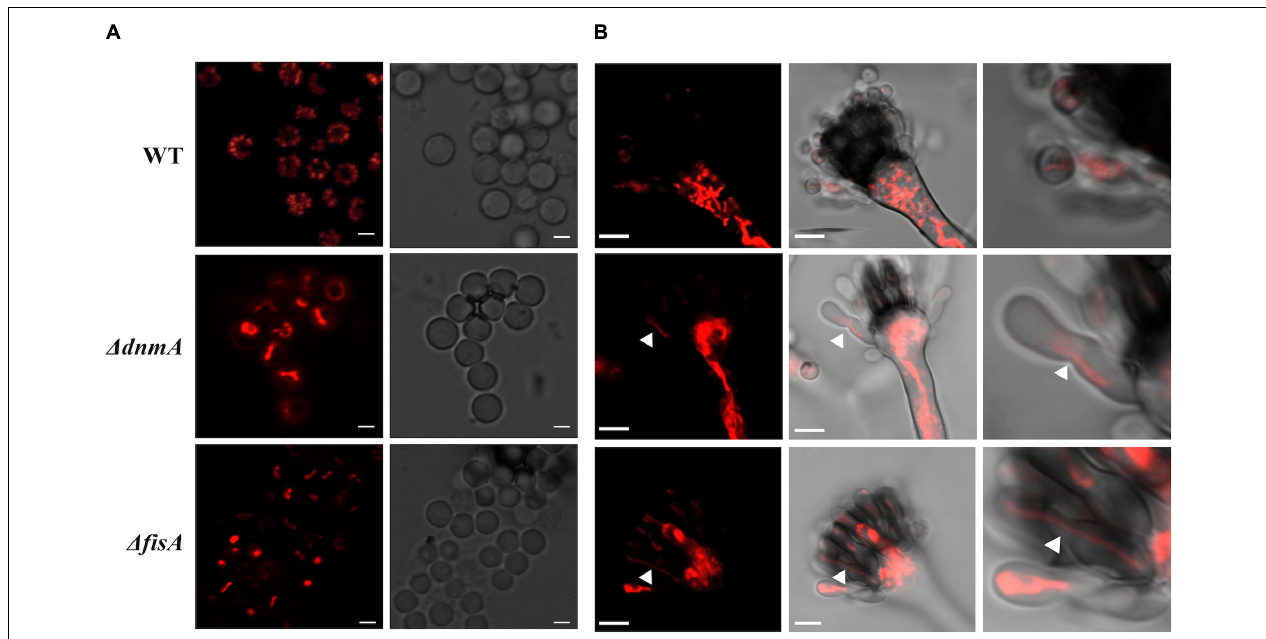
FIGURE 4 | Mitochondrial inheritance during asexual development in WT, (cid:49) dnmA , and (cid:49) fisA strains. (A) Isolated conidia from strains TRV1 (WT), CVG1 ( (cid:49) dnmA ), and CVG2 ( (cid:49) fisA ) were observed by using confocal microscopy. (B) Developing conidiophores from the same strains were also observed under the same conditions. The right panels show a magnification from a section of the middle panels. White arrowheads in (cid:49) dnmA and (cid:49) fisA mutant panels point to mitochondrial filaments located between metulae and nascent phialide cells. White bars = 2 and 5 µ